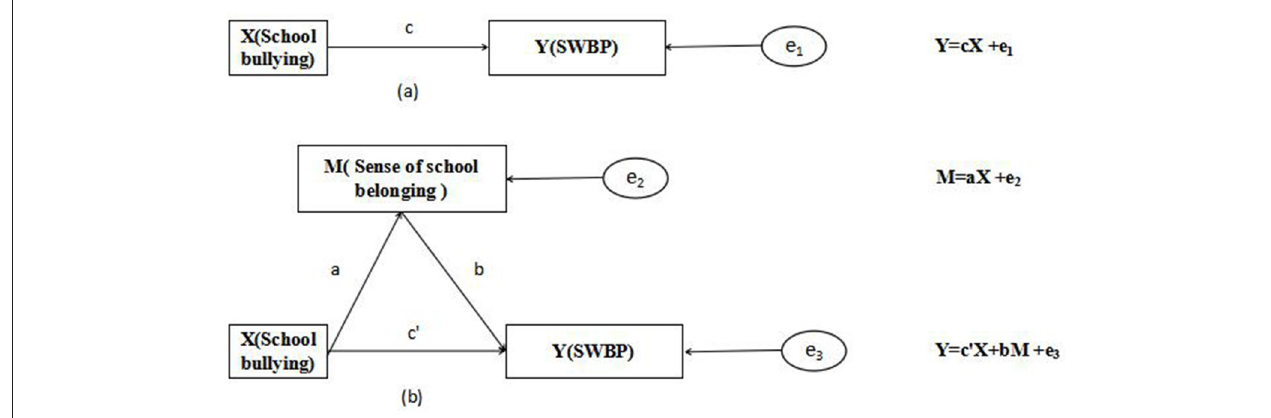
FIGURE 1 | The setting of the mediating effect model.